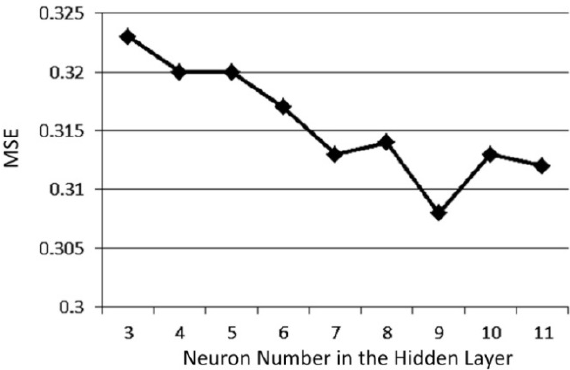
Figure 6. Mean Square Error (MSE) vs . neuron number in the hidden layer (Levenberg-Marquardt method).